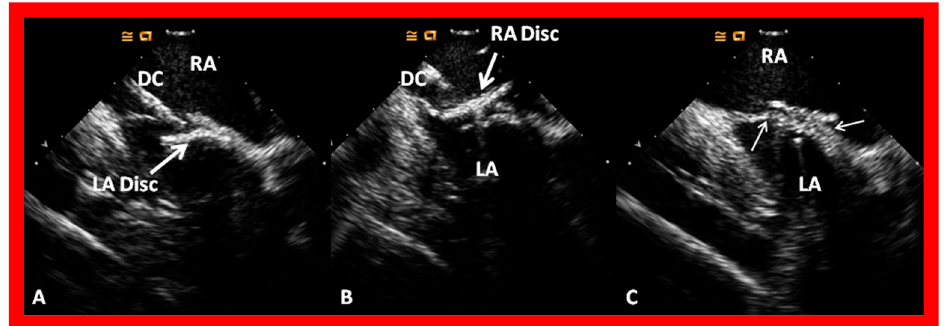
Figure 30. Intracardiac echocardiographic (ICE) images secured during Gore HELEX device deploy- ment to occlude an atrial septal defect (ASD) illustrating the position of the device components. ( A ) The left atrial disc (LA Disc) is in the left atrium (LA). ( B ) The right atrial disc (RA Disc) is in the right atrium. ( C ) The LA and RA discs are on either side of the atrial septum after detachment of device delivery catheter (DC) from the device. Note that the margins of the ASD (thin arrows) are sandwiched in-between LA and RA discs. Replicated from Reference [7].